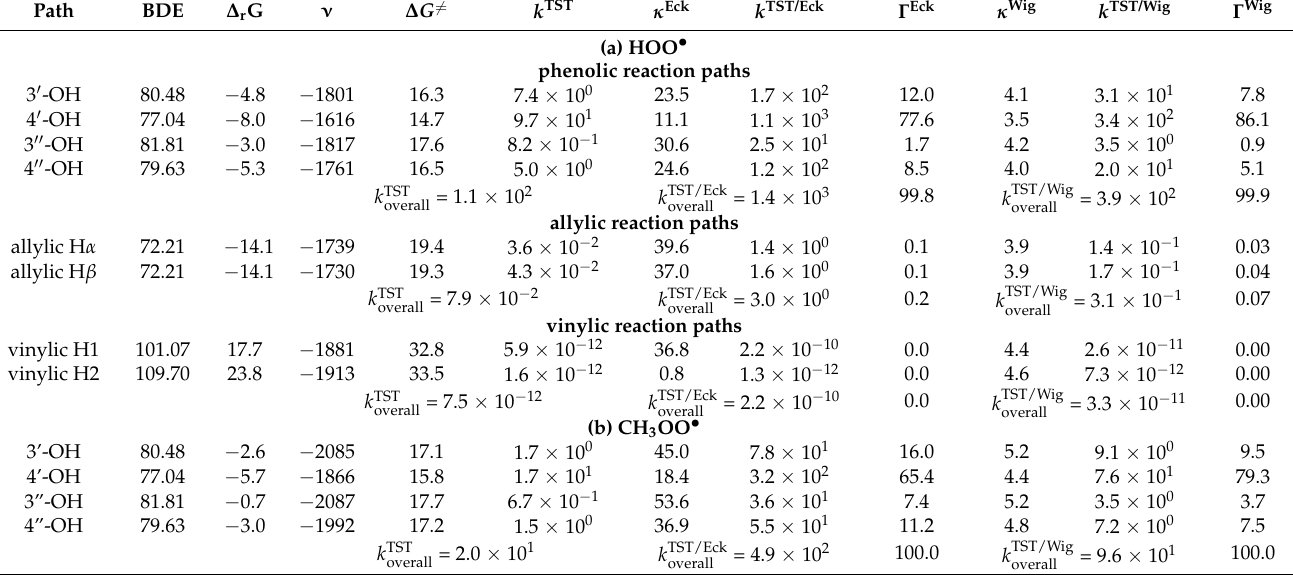
and CH 3 OO • , in pentyl ethanoate at 298.15 K. k TST constants of all reaction paths. For denotation of allylic and vinylic reaction paths see Figure